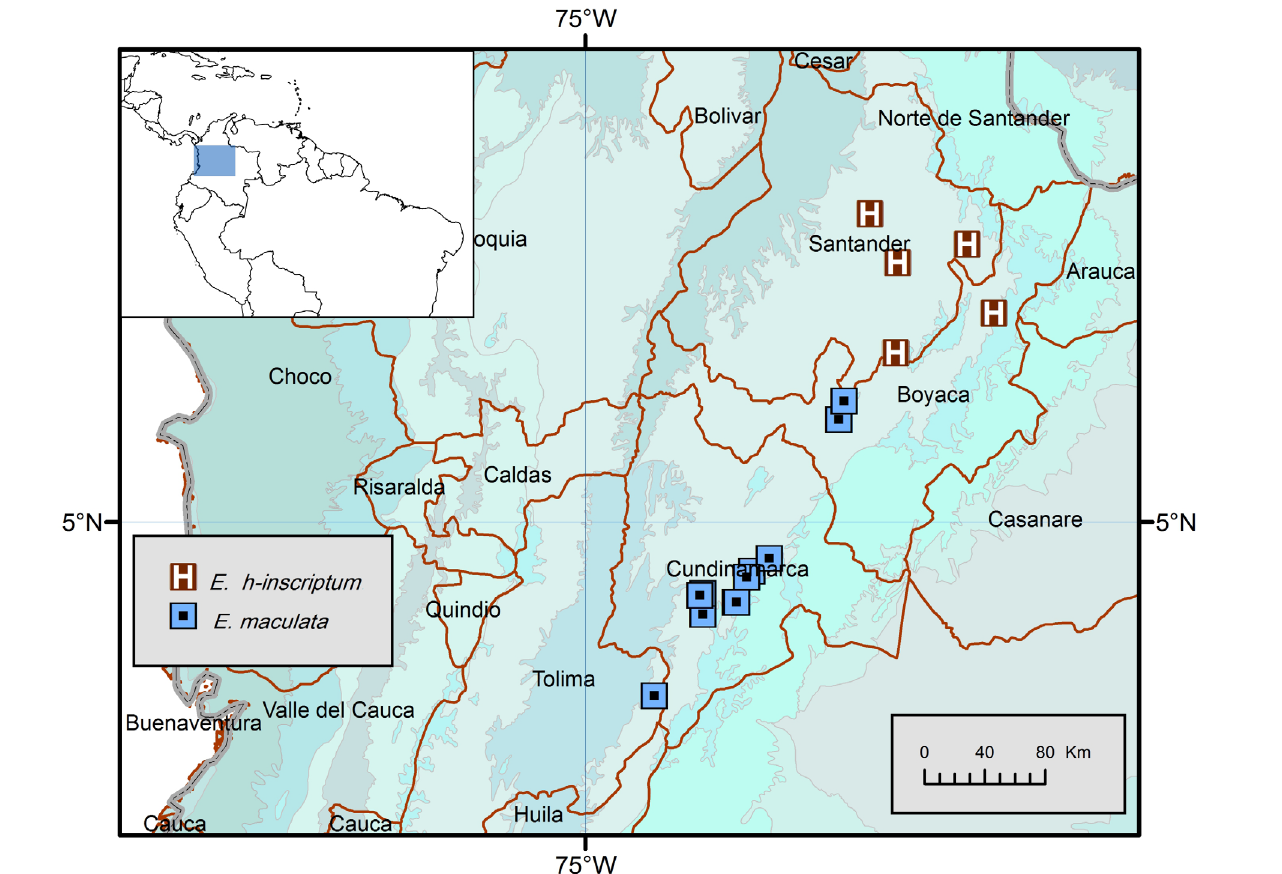
Fig. 32. Northern Andes in Colombia, showing localities for Eulibitia maculata Roewer, 1912 and E. h-inscriptum (Mello-Leitão, 1941) comb. nov. Colored patches on the background represent WWF